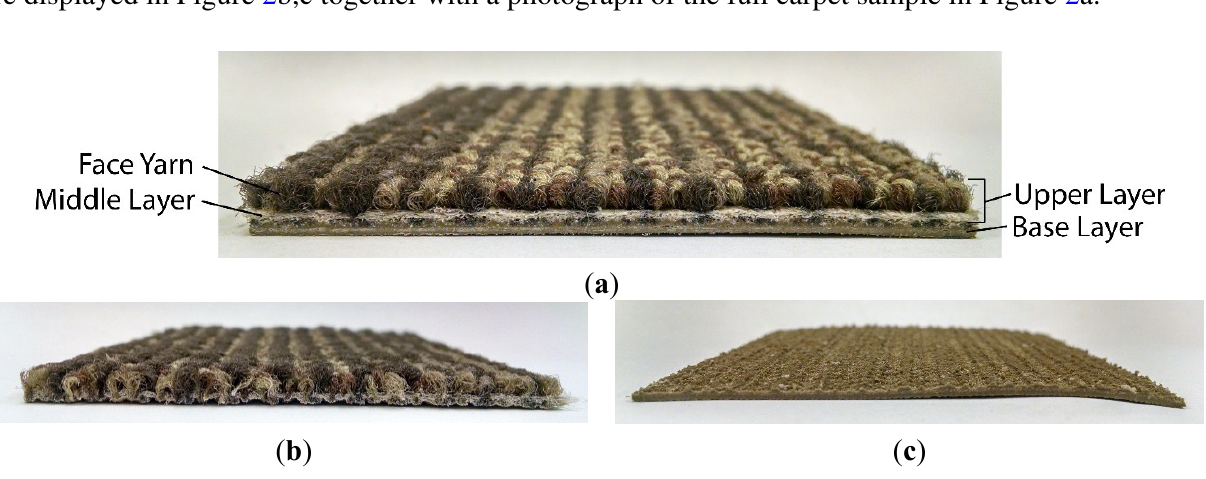
Figure 2. Photographs of ( a ) full carpet composite; ( b ) upper layer; and ( c ) base layer.